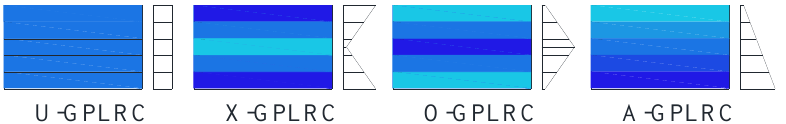
Figure 2. Different graphene nanoplatelets (GPL) distribution patterns in a multilayer FG-GPLRC shallow arch.